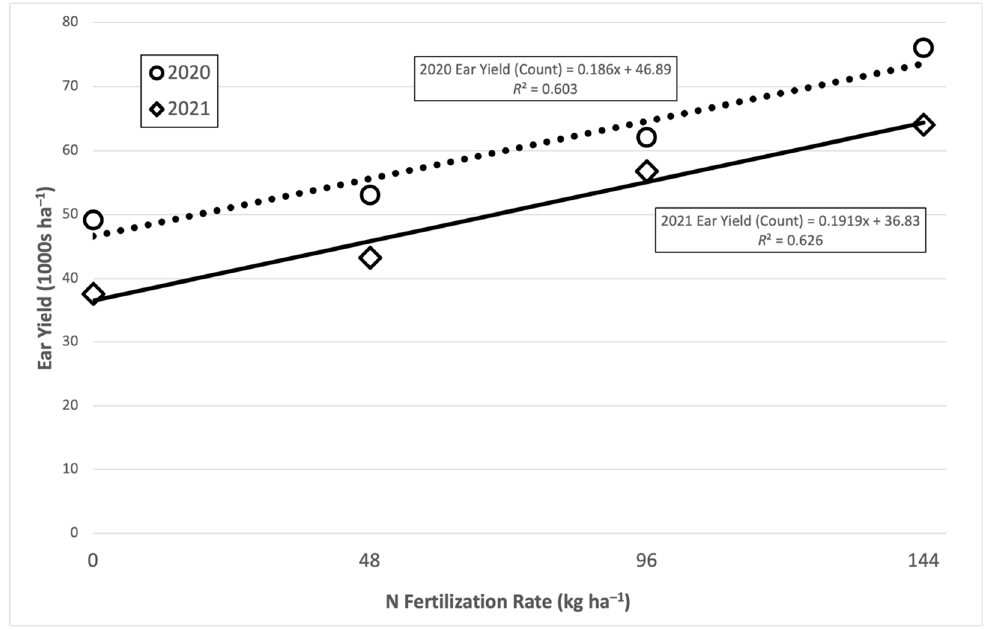
Figure 4. Mean sweet corn yield by number of ears as a function of N fertilization rate in 2020 and 2021. Goodness of fit described with conditional R 2 .